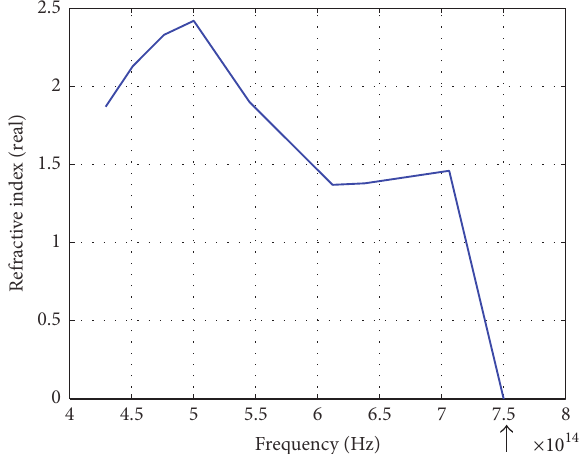
Figure20:Plotshowinghowtherefractiveindex(real)changeswith frequency for a radius ratio of 2 and fixed inner and outer radius value (arrow shows the value reaches zero at a frequency of 7.5 THz).